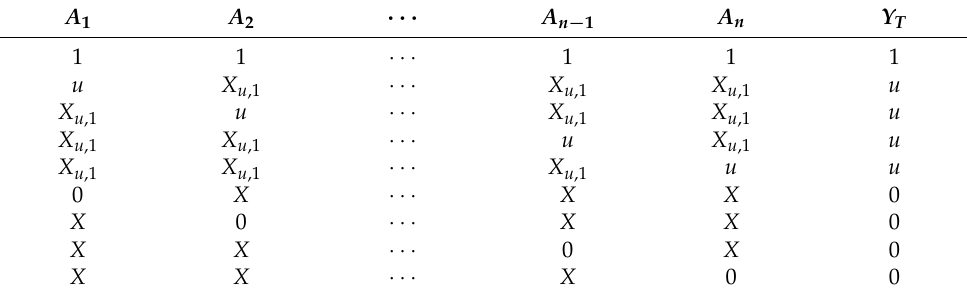
Table 12. Kleene extension of the encoding for activation with all sets on input.